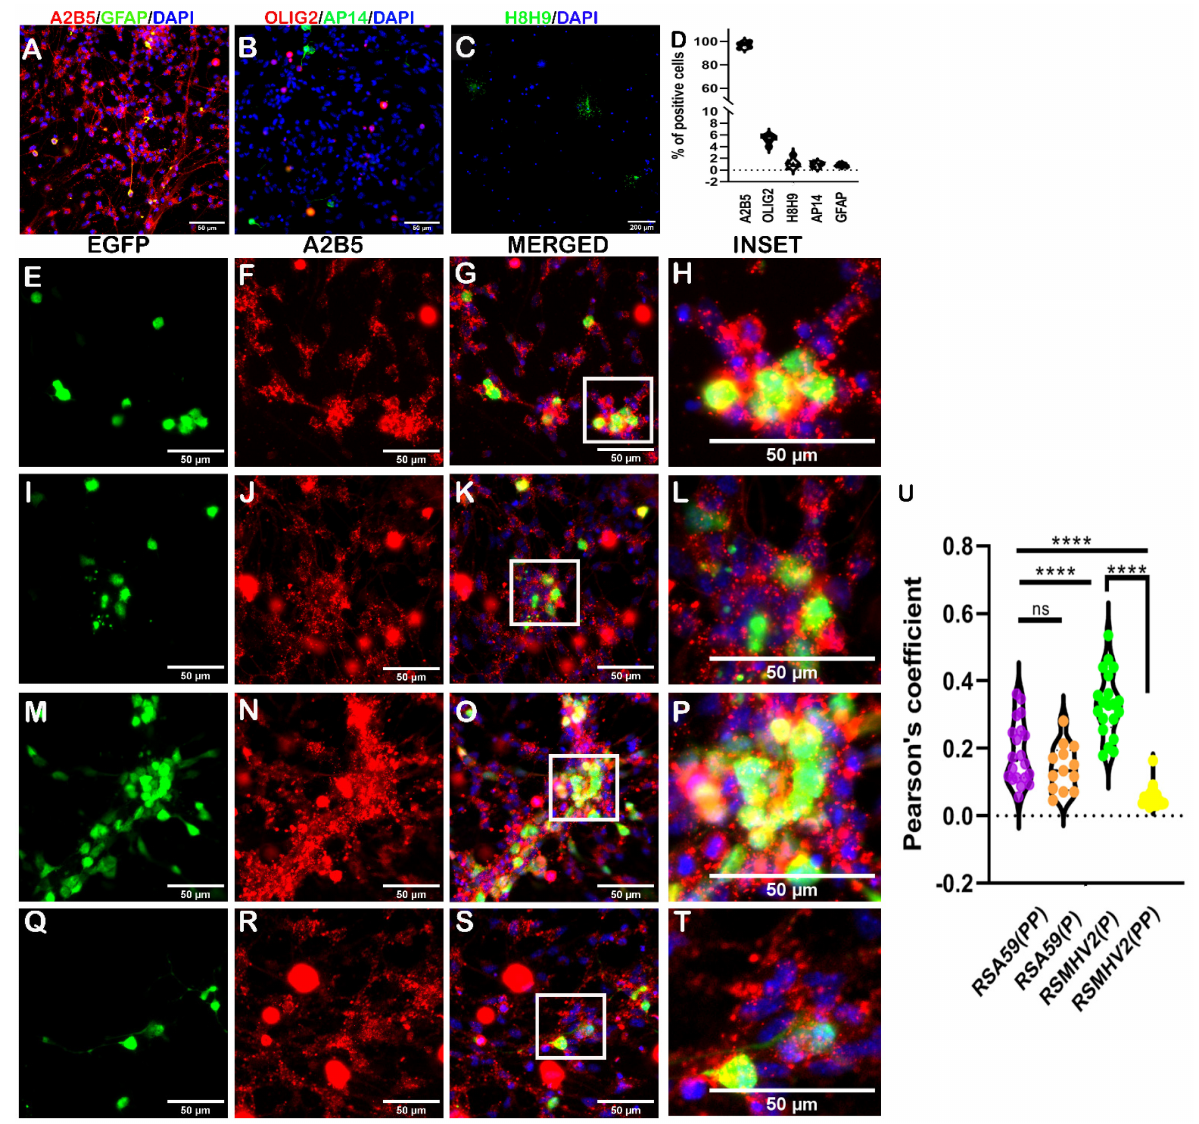
Figure 7. Characterization and infection of oligodendrocyte precursor enriched primary cultures with two proline containing strains RSA59 (PP), and RSMHV2(PP), and single proline containing strains RSA59(P), and RSMHV2(P). Oligodendrocyte precursor cells (OPCs) enriched from mixed glial cultures were immunolabeled with anti-A2B5 (Red; OPCs marker) and anti-GFAP (Green; astrocyte marker) ( A ), anti-Olig2 (Red; mature oligodendrocyte) and anti-AP14 (Green; mature neuron) ( B ), and anti-H8H9 (differentiated oligodendrocyte) ( C ). Cells were DAPI counterstained (Blue; nuclear stain). Visual counting and manual analysis of immunostained cells demonstrated that cultures were mostly A2B5-positive at 98%, with few cells positive for mature oligodendrocytes ( D ). OPCs cultures were infected with RSA59(PP) ( E – G ), RSA59(P) ( I – L ), RSMHV2(P) ( M – P ), and RSMHV2(PP) ( Q – T ) at MOI 2. Cells were immunolabeled with A2B5 at 24 h p.i. and counterstained with DAPI. Images presented show infected cells in the EGFP panels and A2B5 panels denote OPCs in the culture. Merged panels show the OPCs and EGFP colocalization. Panels ( H , L , P , T ) show higher magnification of colocalization in insets highlighted by a white rectangle area in merged images. A quantified percentage of infected OPCs was presented in a violin diagram ( U ). Experiments were performed three times in triplicate per strain (N = 9). The level of significance was taken at p < 0.05 following One-way ANOVA analysis. **** p < 0.00001, and ns denotes